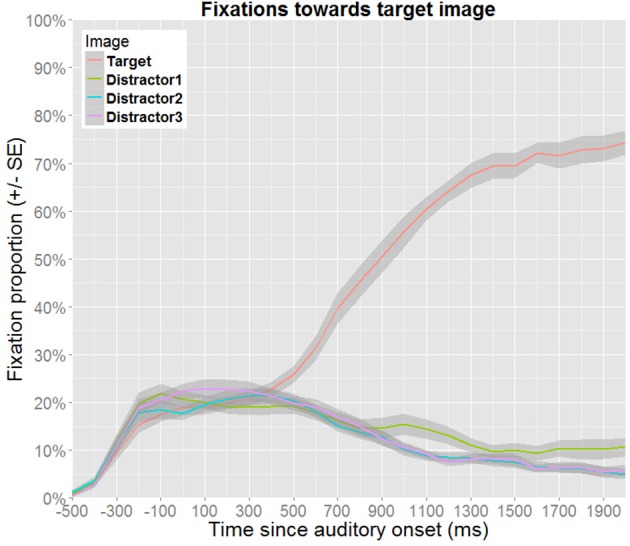
Proportion of fixations toward the target image as a function of time for no competitor trials. Proportions were calculated as subject means over 100 ms bins. Note that Distractor1 is the distractor that has the same gender as the target. Thus, the increased fixation proportion toward this distractor in the late time window reflects rhyme competition (as gender information from the suffix becomes available).